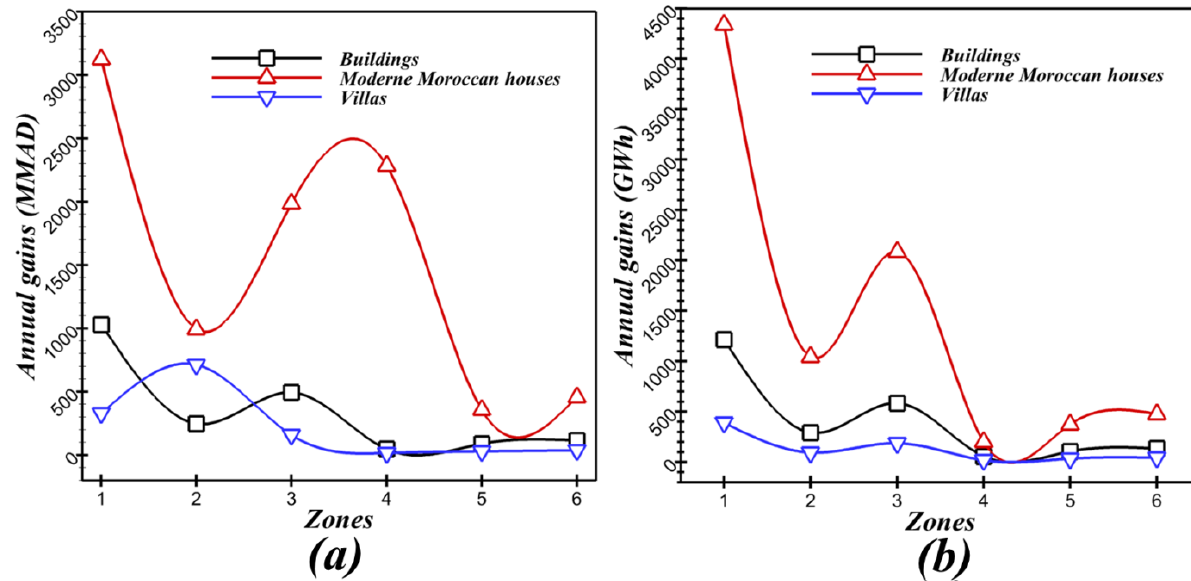
Figure 14. ( a ) Total annual gains (with state subsidies). ( b ) Total annual gains (without state subsidies).